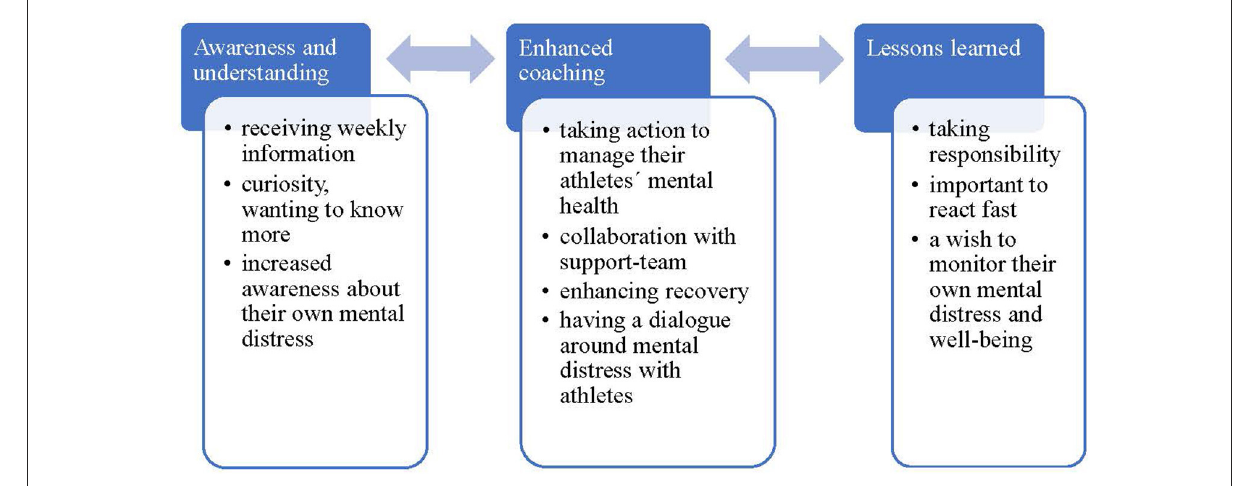
FIGURE1 How coaches perceive monitoring of their athletes’ mental